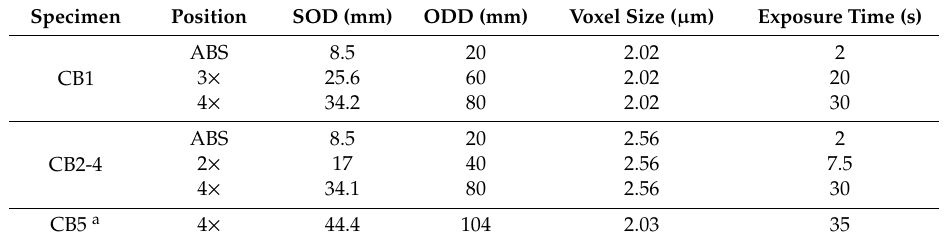
Table 1. Summary of source-to-object distance (SOD), object-to-detector distance (ODD), voxel size and exposure time for all